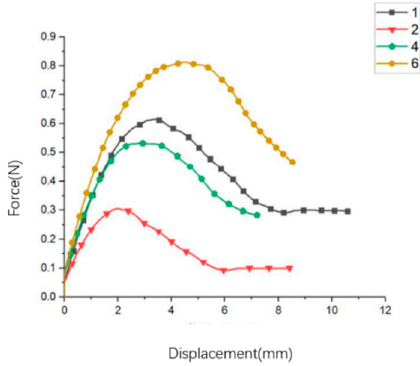
Figure 6. Curve of the stem bending of hairy vetch.